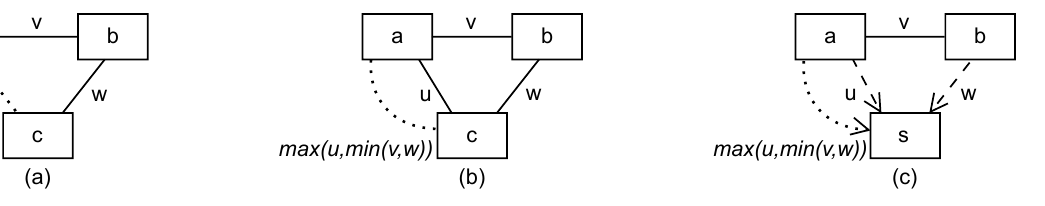
Figure 11. Cases describing how the linkability attribute of the linkable and related to relations are determined for the transitive closure of them. ( a ) Linkable relation exists between a and b , but not between a and c ; ( b ) Linkable relations exist between a , b , and c ; ( c ) a and b are related to S and a linkable relation between a and b